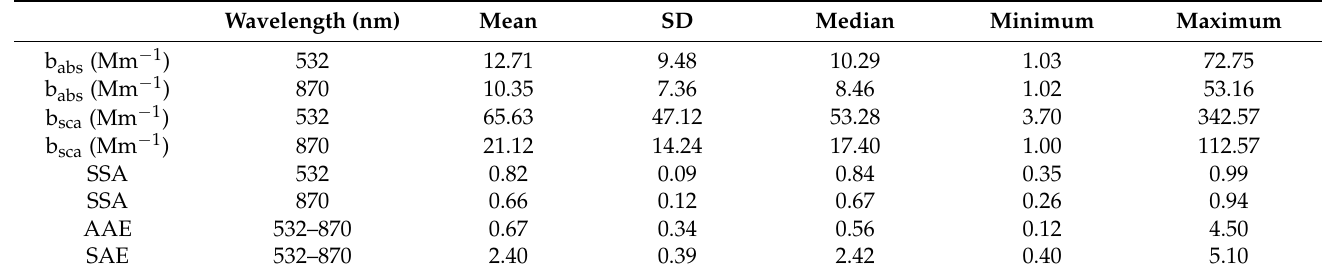
Table 1. Statistical summary of PM 2 . 5 optical properties for ACU15 Campaign.